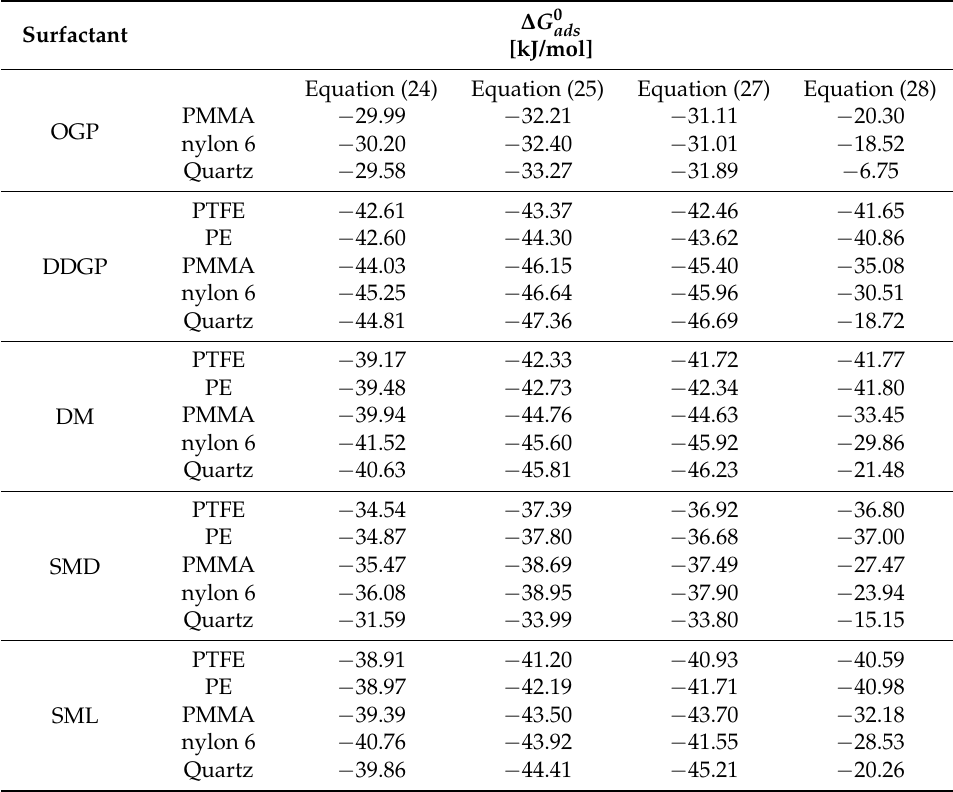
Table 5. The values of standard Gibbs free energy ( ∆ G 0 adsorption at the solid–water